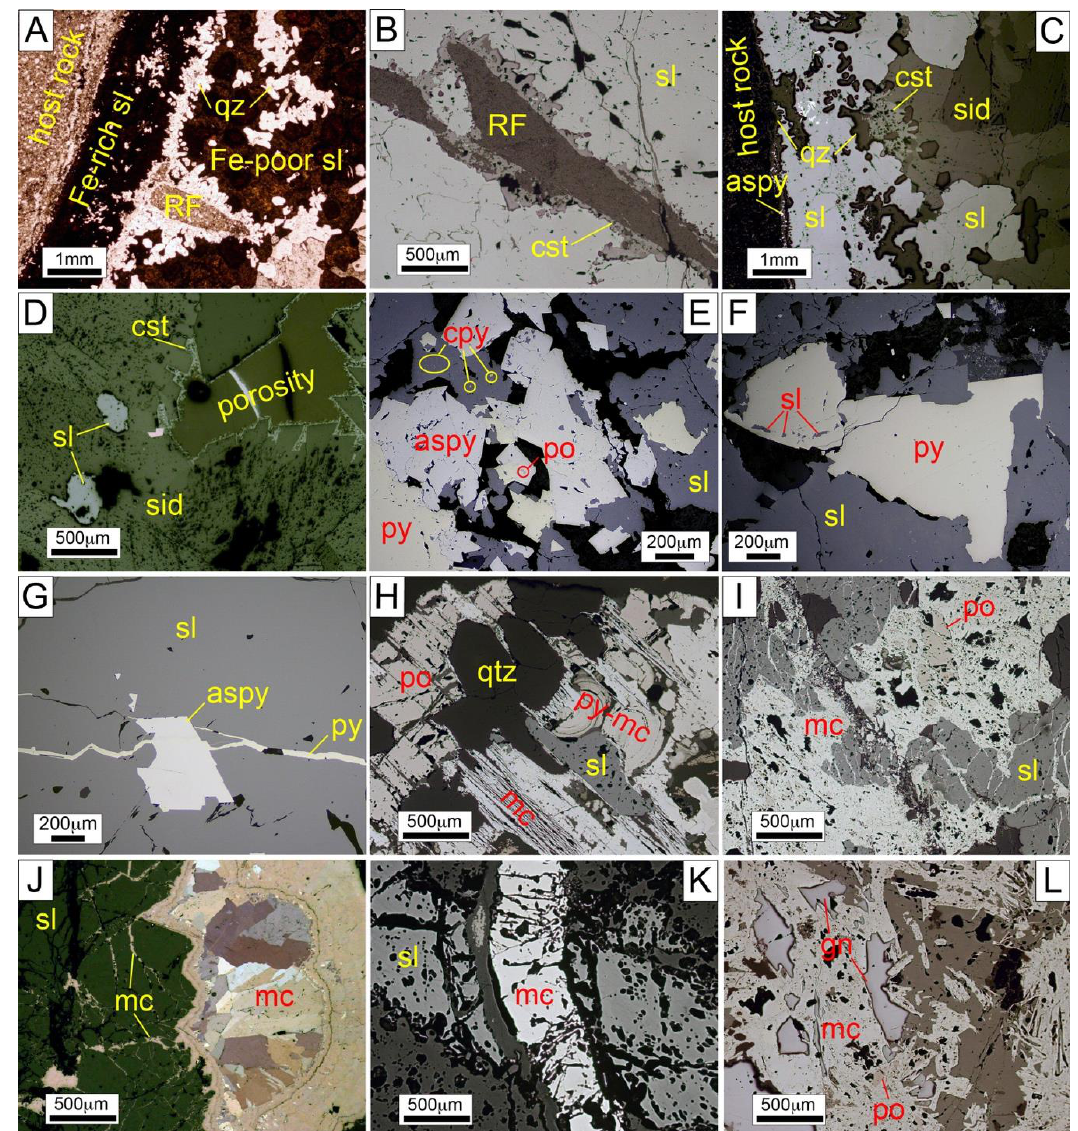
Figure 5. Photomicrographs of representative polymetallic vein mineralization in the Huari Huari district. ( A ) General view of the contact between a silicified host and a sphalerite-rich vein. Note that a first band of Fe-rich (dark) sphalerite is overgrown by slender subhedral quartz crystals, which also wrap rock fragments, thus drawing a cockade texture. A later generation of sphalerite, towards the core of the vein, is relatively poor in Fe (dark red in the image: transmitted, plane-polarized light). ( B ) Needle tin cassiterite coating a fragment of silicified host rock enclosed in sphalerite and partially replaced and overgrown by massive sphalerite (reflected light). ( C ) Banded vein showing an outer narrow layer of arsenopyrite and quartz, inner layers of younger sphalerite and cassiterite, and a central filling of siderite (reflected light). ( D ) Slender needle tin cassiterite developed inward central porosity along a siderite–sphalerite vein (reflected light). ( E ) Subhedral crystals of arsenopyrite and pyrite show conspicuous engulfment and microporosity filled with sphalerite. Sphalerite contains numerous chalcopyrite blebs (reflected light). ( F ) Sphalerite surrounds and fills porosity in anhedral, engulfed pyrite crystals (reflected light). ( G ) Early arsenopyrite, partly replaced by sphalerite, veined by pyrite (reflected light). ( H ) Early pyrrhotite pervasively replaced by sphalerite, pyrite (showing “bird’s eye” textures developed by concentric growths of pyrite in early stages of pyrrhotite replacement) and marcasite; the latter concentrates along the contacts between the other phases (reflected light). ( I ) Marcasite forms microscopic veinlets penetrating pyrrhotite and sphalerite